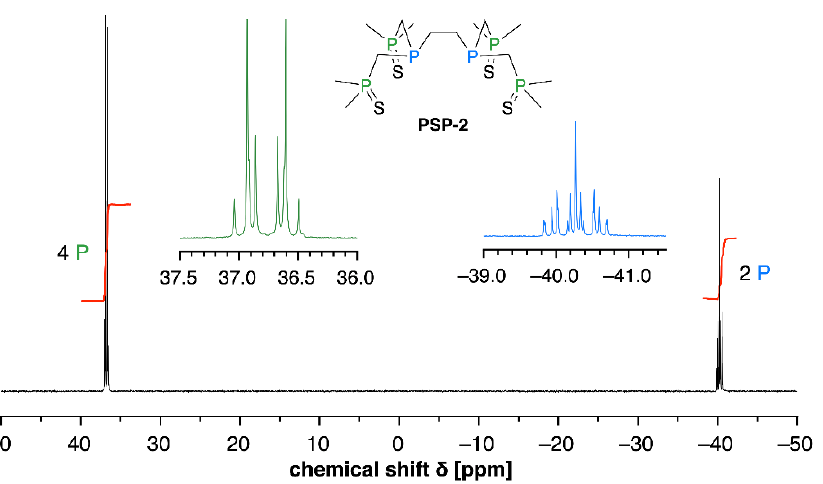
Figure 1. 31 P-NMR spectrum of PSP-2 to verify its integrity towards oxidation after prolonged storage in DMSO. The two signals can be assigned to the phosphine sulfides moiety centered around 37 ppm (green) and the tertiary phosphines around − 40 ppm (blue), respectively [32]. The absence of additional signals confirms the oxidative stability of PSP-2 in